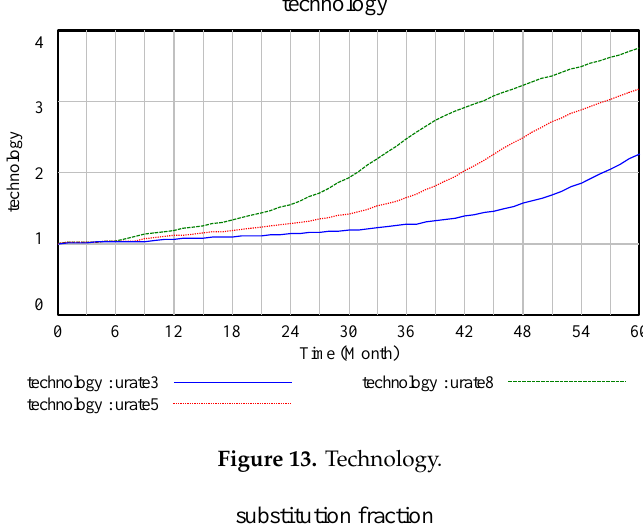
Figure 13. Technology.